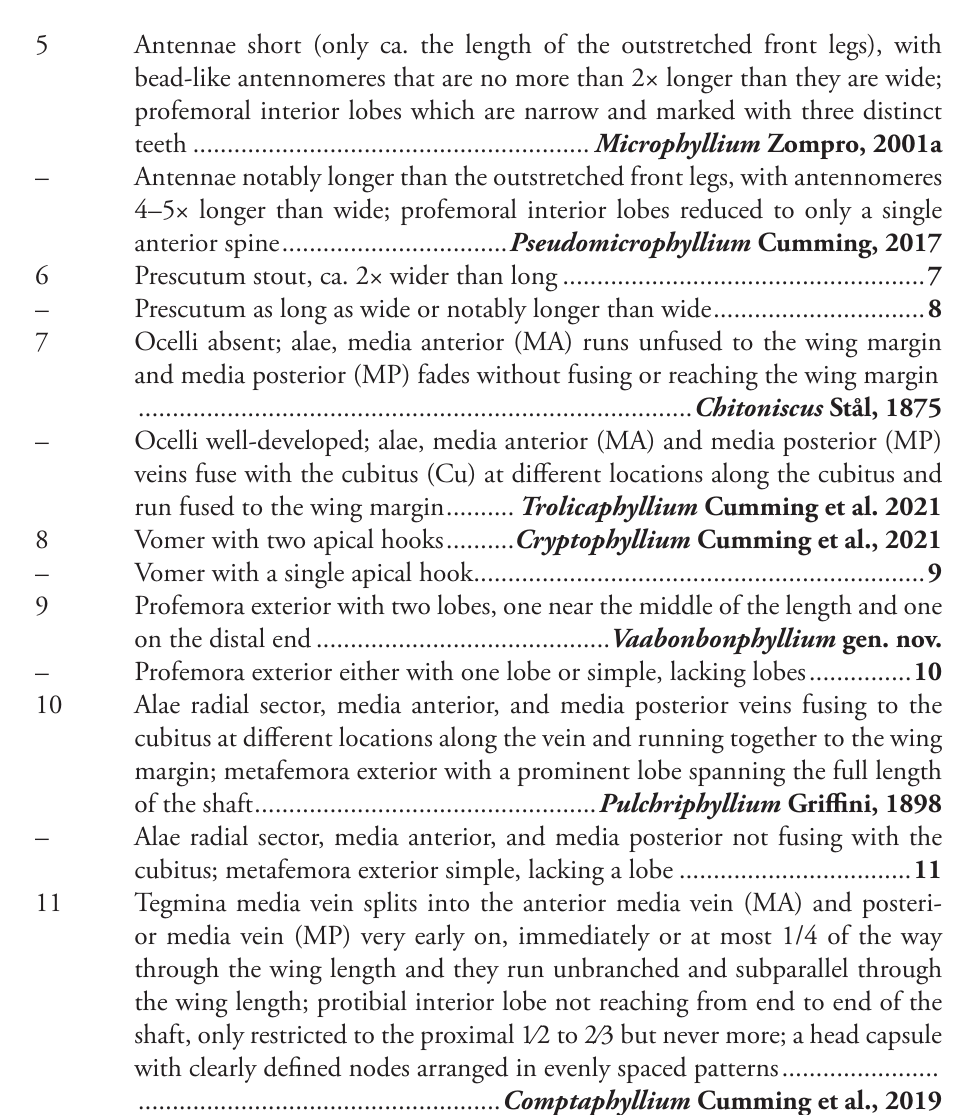
Antennae short (only ca. the length of the outstretched front legs), with bead-like antennomeres that are no more than 2× longer than they are wide; profemoral interior lobes which are narrow and marked with three distinct – Antennae notably longer than the outstretched front legs, with antennomeres 4–5× longer than wide; profemoral interior lobes reduced to only a single 6 Prescutum stout, ca. 2× wider than long ..................................................... 7 – Prescutum as long as wide or notably longer than wide ............................... 8 7 Ocelli absent; alae, media anterior (MA) runs unfused to the wing margin and media posterior (MP) fades without fusing or reaching the wing margin – Ocelli well-developed; alae, media anterior (MA) and media posterior (MP) veins fuse with the cubitus (Cu) at different locations along the cubitus and run fused to the wing margin .......... Trolicaphyllium Cumming et al. 2021 8 Vomer with two apical hooks .......... Cryptophyllium Cumming et al., 2021 – 9 Profemora exterior with two lobes, one near the middle of the length and one on the distal end ........................................... Vaabonbonphyllium gen. nov. – Profemora exterior either with one lobe or simple, lacking lobes ............... 10 10 Alae radial sector, media anterior, and media posterior veins fusing to the cubitus at different locations along the vein and running together to the wing margin; metafemora exterior with a prominent lobe spanning the full length of the shaft .................................................. Pulchriphyllium Griffini, 1898 – Alae radial sector, media anterior, and media posterior not fusing with the cubitus; metafemora exterior simple, lacking a lobe .................................. 11 11 Tegmina media vein splits into the anterior media vein (MA) and posteri- or media vein (MP) very early on, immediately or at most 1/4 of the way through the wing length and they run unbranched and subparallel through the wing length; protibial interior lobe not reaching from end to end of the shaft, only restricted to the proximal 1⁄2 to 2⁄3 but never more; a head capsule with clearly defined nodes arranged in evenly spaced patterns ....................... – Tegmina media vein running unbranched for the first 1⁄3 to 2⁄5 of the wing length, and then branching with either a single short media posterior running to the wing margin or two short media posteriors branching from the nota- bly longer media anterior and running to the margin; protibial interior lobe variable, either fully spanning the full length or only 1⁄2 of the length; head capsule at most with random granulation but frequently bare ................... 12 12 Abdominal shape rectangular, with segments V and VI with fully parallel- sided margins (segments IV and VII with only half parallel-sided and the remainder curved) ........................... Walaphyllium Cumming et al., 2020b – Abdominal shape variable, either spade-shaped (with the margins of V paral- lel or strongly converging and segment VI strongly converging), ovular